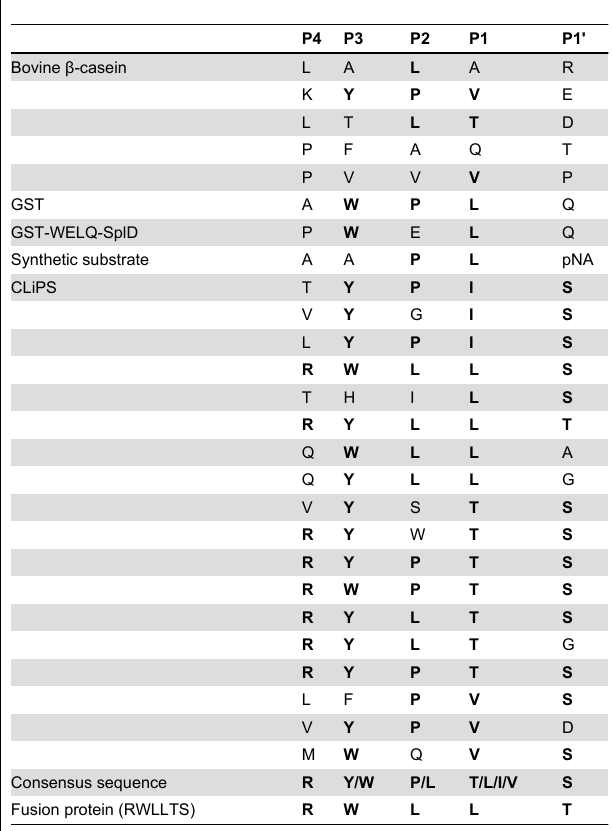
Table 2. Data collection and refinement